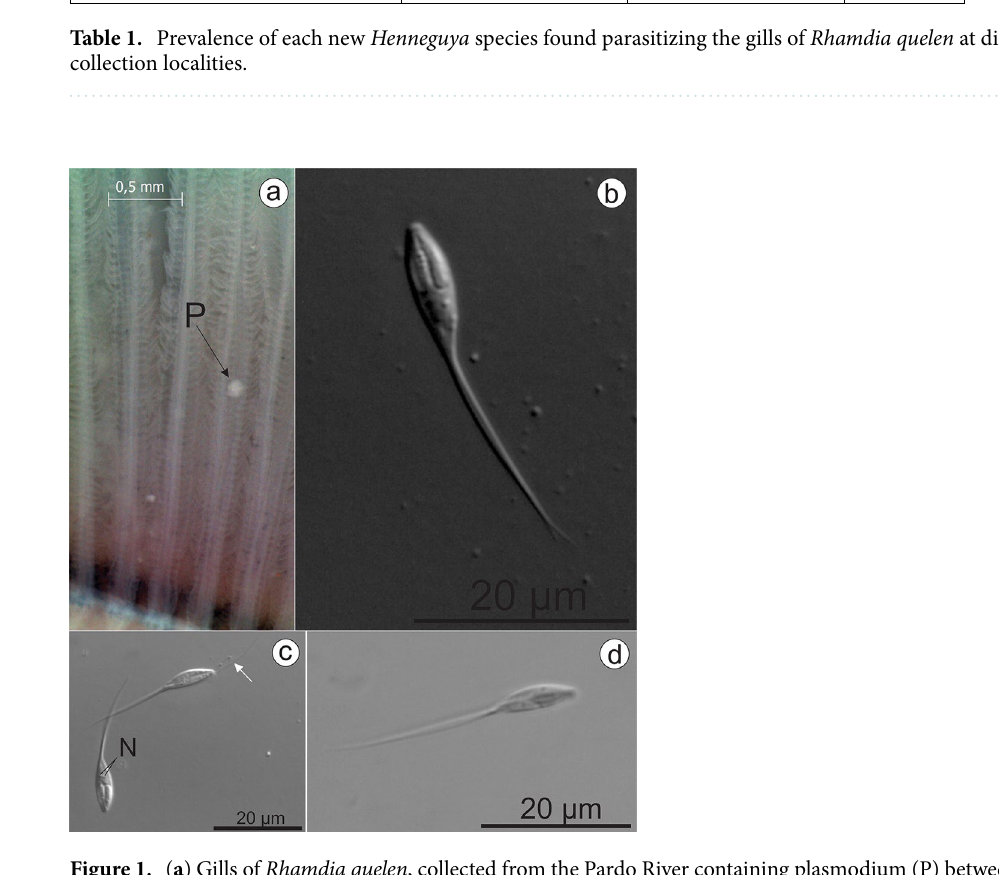
Figure 1. ( a ) Gills of Rhamdia quelen , collected from the Pardo River containing plasmodium (P) between the gill filaments. ( b ) Mature myxospore of Henneguya novaerae n. sp. found parasitizing the gills in front view, showing two equally-sized elongated polar capsules located side by side at the previous pole. ( c ) Mature myxospores of Henneguya novaerae n. sp. Note the nucleus (N) and the extruded tubule (white arrow). ( d ) Henneguya novaerae n. sp. myxospore in side